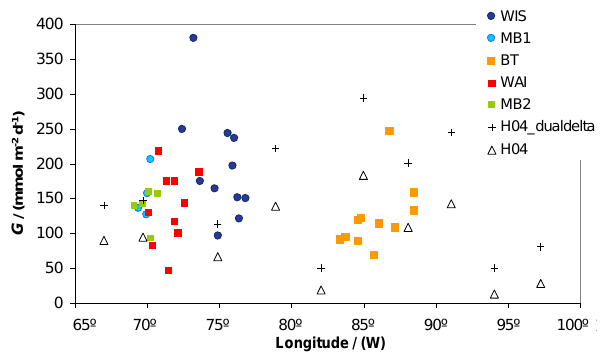
Fig. 10. Longitudinal distribution of G (average of G 1 and G 2 ) . Comparison to results obtained by Hendricks et al. (2004) (H04) during March 2000 using 17 ∆ and recalculated values (H04 dualdelta) using 17 δ and 18 δ